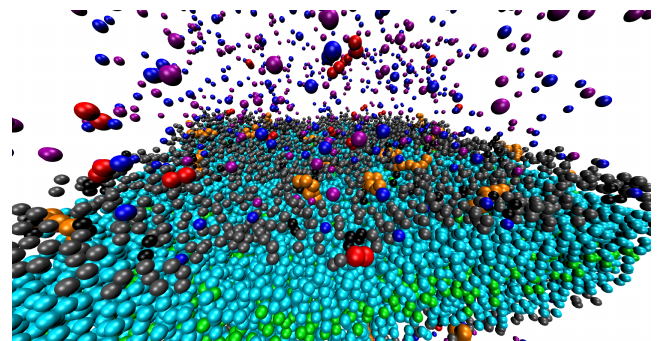
Figure 6. Snapshot from simulation with 50 divalent cations and 32 β -peptides. Negatively charged phospholipid head (Hq), black; electroneutral phospholipid head (H), gray; glycerol (G), yellow; hydrophobic tail (C), cyan; end-bead of the tail (E), green; β -peptide (P), orange; monovalent cations (Na + ), blue; monovalent anions (Cl − ), purple; divalent cations (Me 2 + ), red; solvent particles (S),